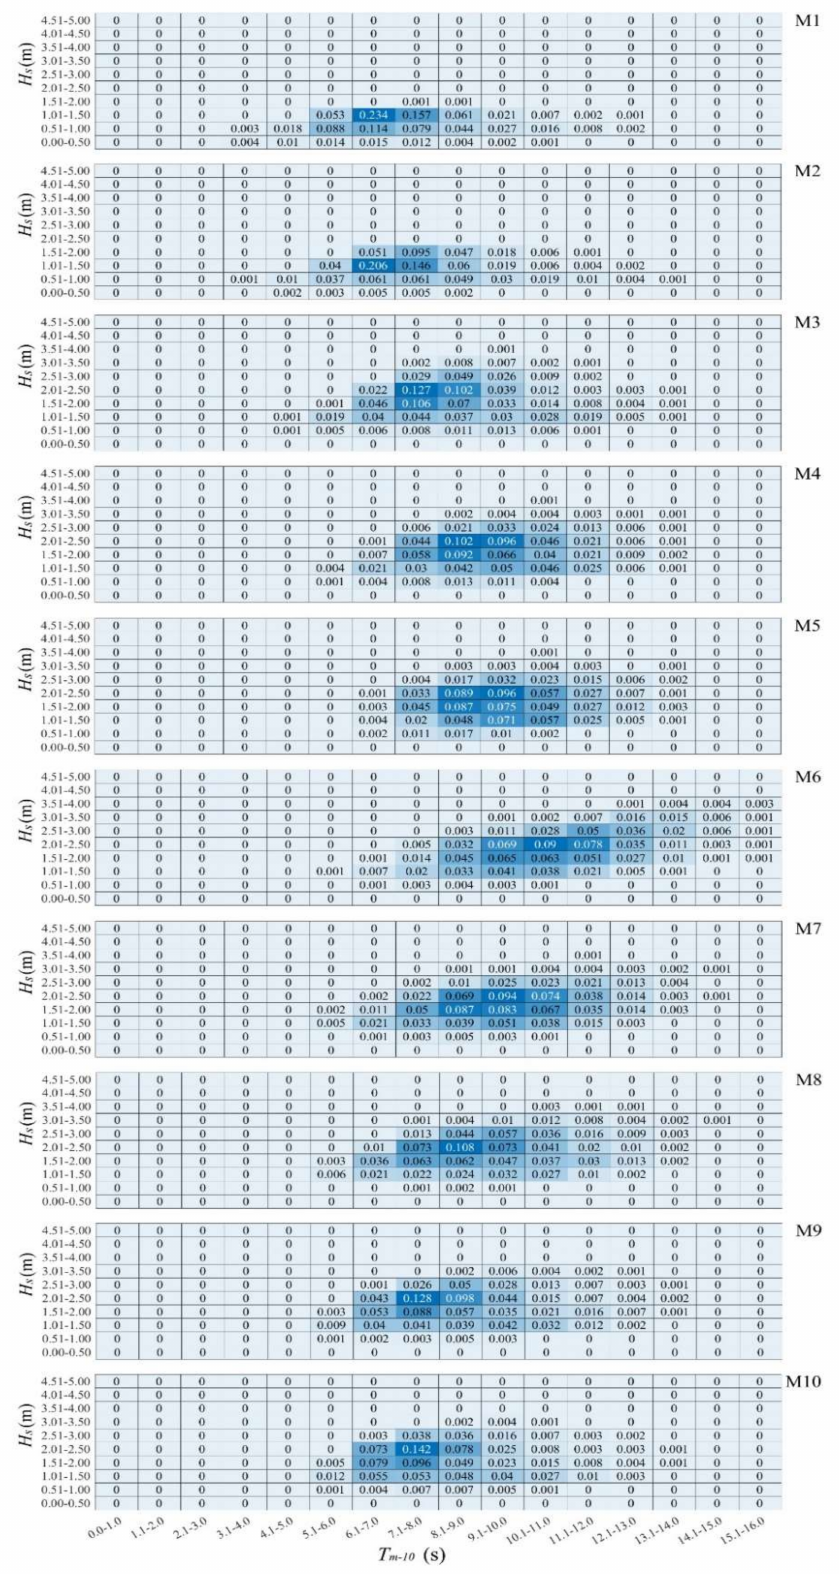
Figure 15. Scatter diagram of available wave power at locations M1–M10 under “future” climate scenario. The power is given as a fraction of power available in each sea state to total power available at the selected